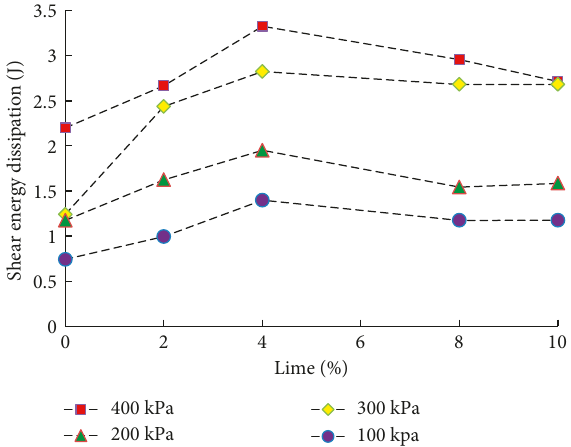
Figure 9: Shear energy dissipation of lime-reinforced iron tailing powder with different lime